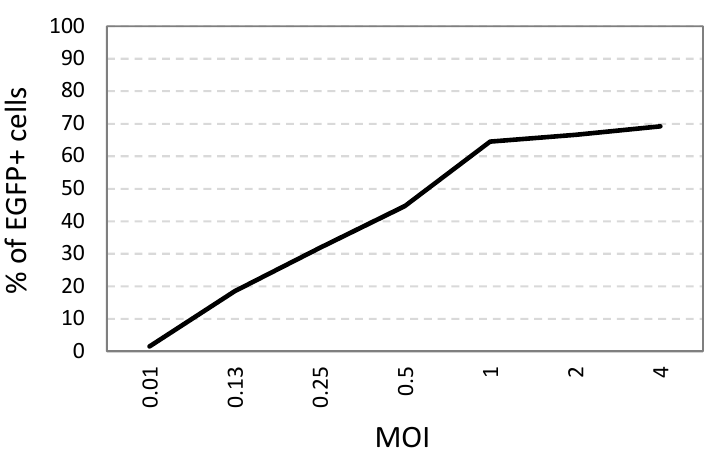
Figure 1. The percentages of ASFV-infected (EGFP+) cells at different MOI (HAD 50 ) in cultured pig ex vivo adherent PBMC, calculated based on flow cytometry analysis gated on the population of monocytes and macrophages.